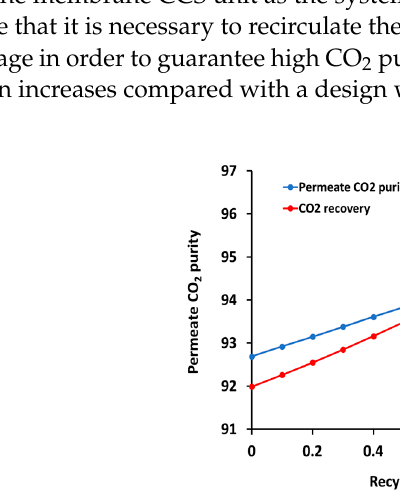
Figure 5. Effect of retentate recycling on the system performance ( left ) total energy requirement ( right ) Permeate CO 2 purity ( right ) Permeate CO 2